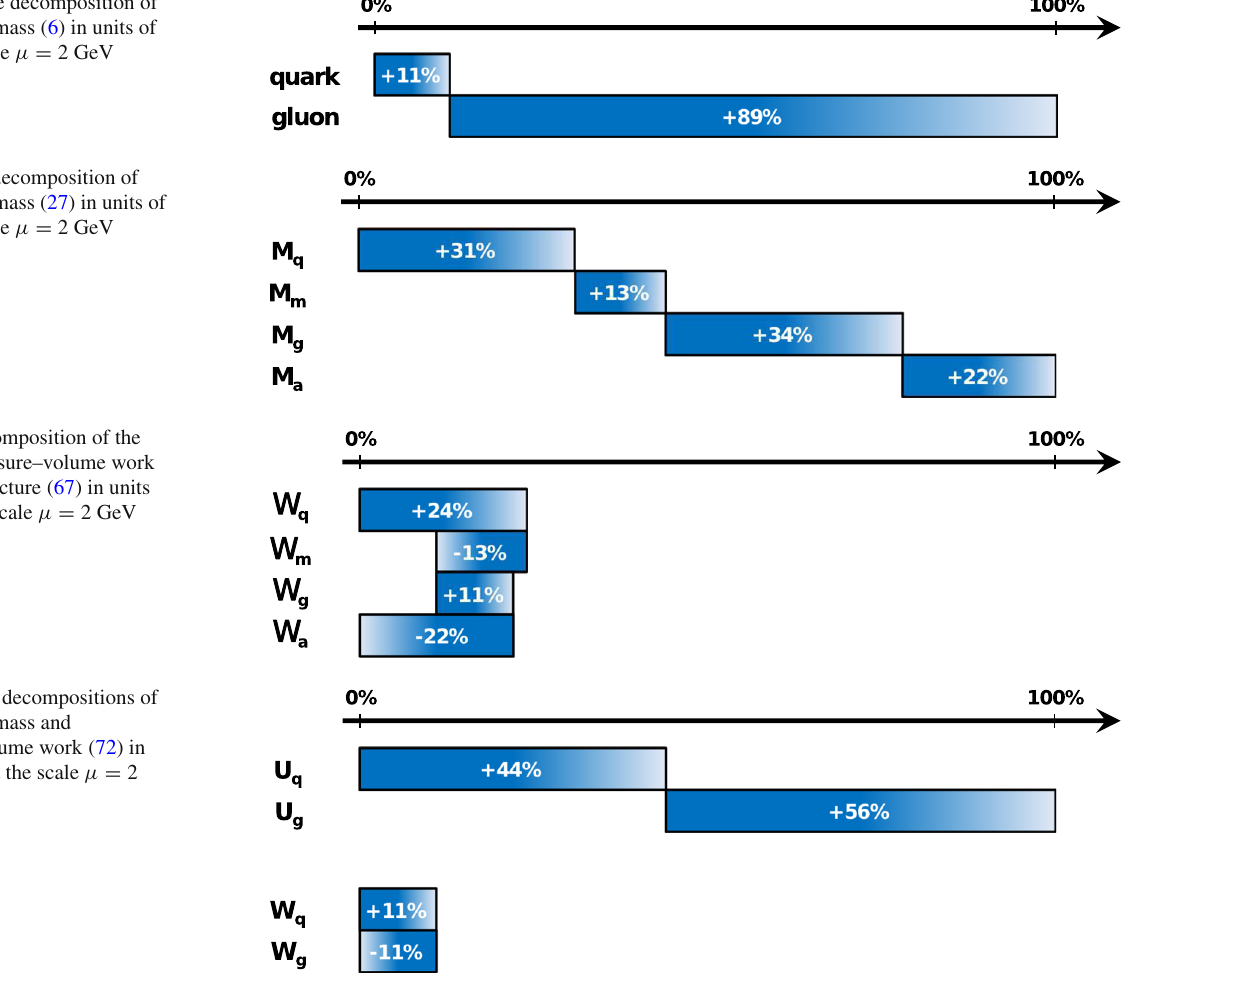
Fig. 2 Ji’s decomposition of the nucleon mass (27) in units of M at the scale μ = 2 GeV